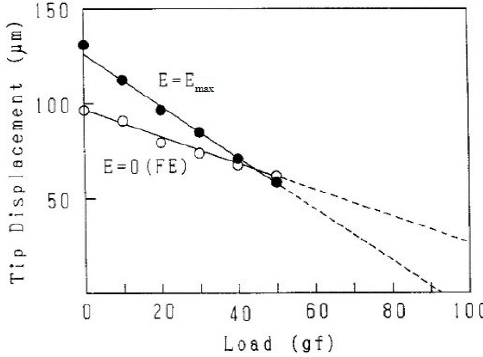
Figure 21. Tip displacement of the shape memory unimorph (y = 0.063) as a function of the external load. Actuators 2016 , 5 , 11